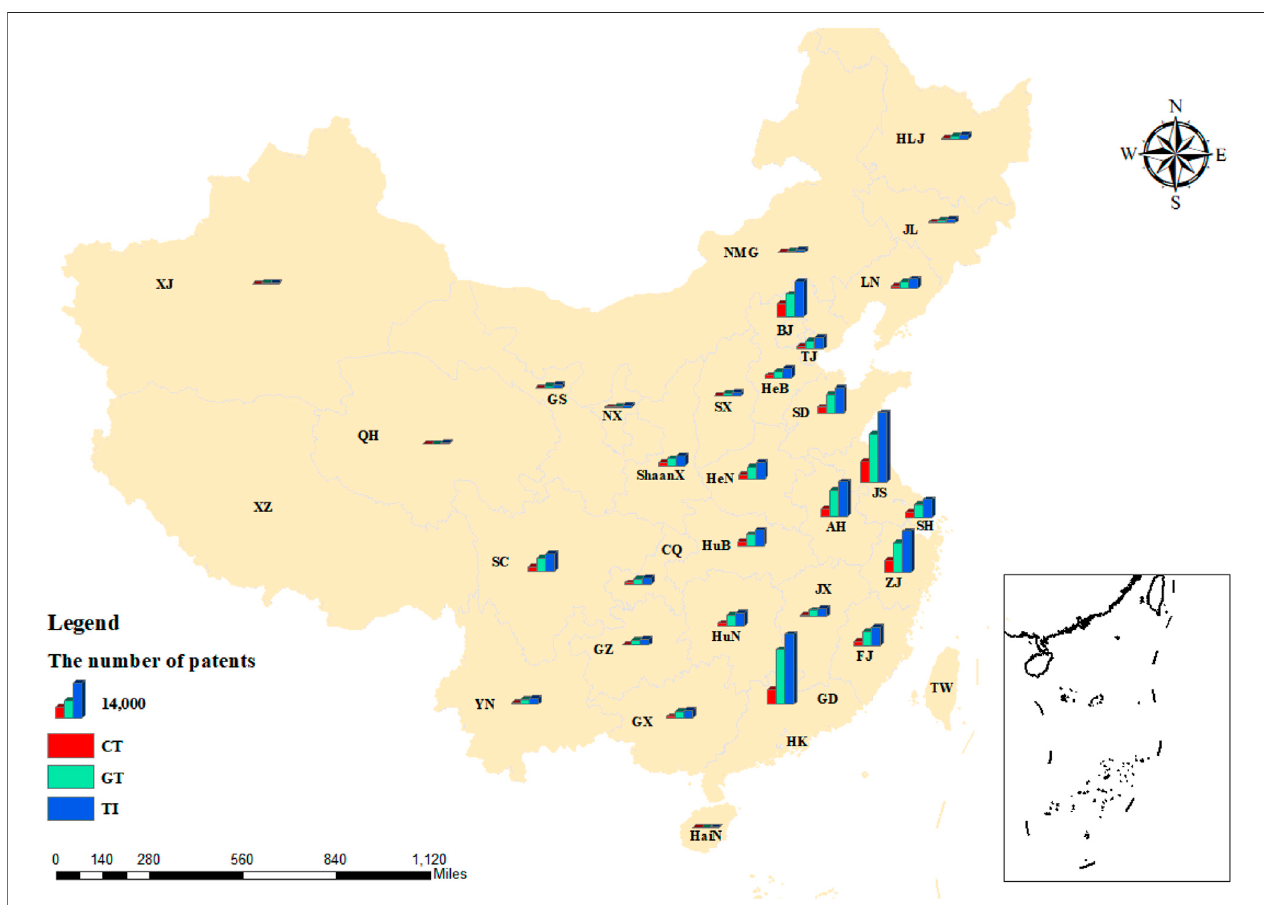
FIGURE 3 | Number of patent applications for low-carbon technologies by provinces in China in 2018.